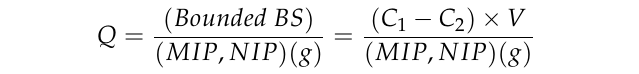
Figure 2. SEM images of ( a ) MIP and ( b ) NIP nanobeads.